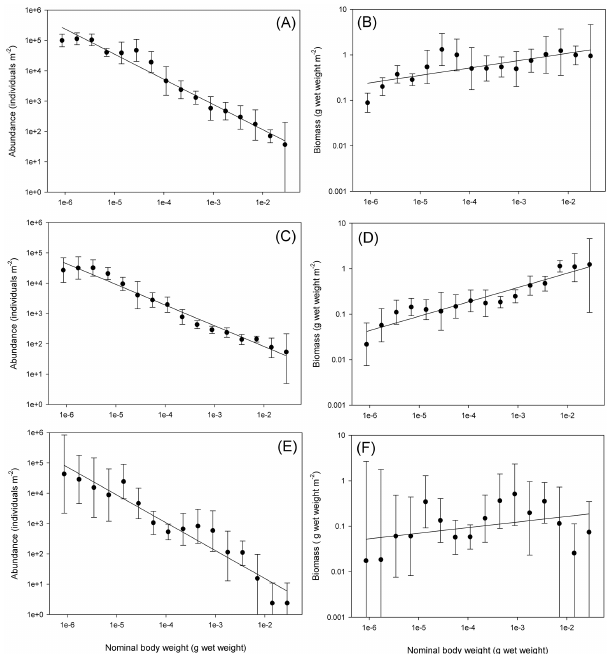
Figure 3. Abundance and biomass spectra for Fladen Ground (a, b) , Faroe–Shetland Channel (c, d) and Oman Margin (e, f) . Geometric mean (points) and 95% confidence intervals (bars) based on five replicate samples are shown together with regression lines for the geometric mean